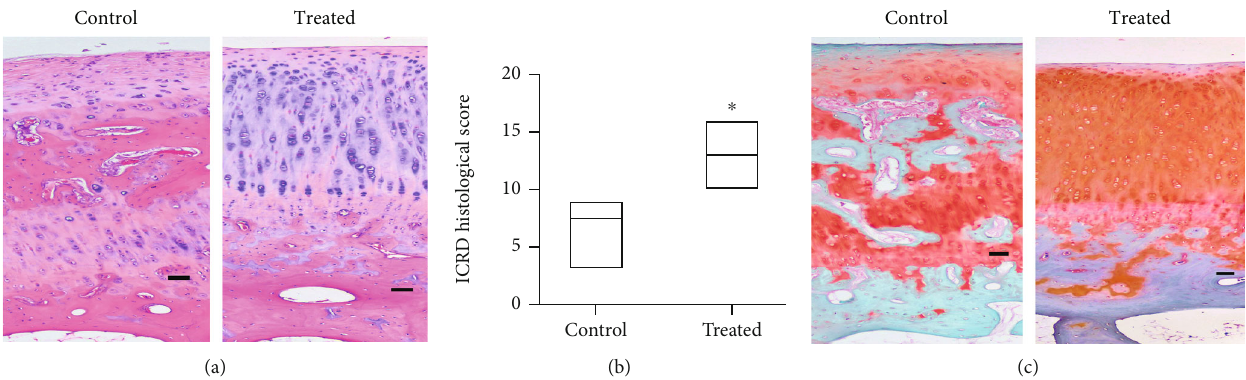
Figure 5: Histology and ICRS score of the rabbit osteoarthritis model after 12 weeks of experiments ( n = 4 ). (a) Representative image of histology of the cartilage in normal saline control and HUCMSC+HA-treated knees. Scale bar = 100 μ m . (b) The normal saline control joints show a signi fi cantly lower ICRS histological score than the joints which receive 1 × 10 7 HUCMSC+HA therapy ( n = 4 , p = 0 : 029 ). (c) The content of Safranin O staining after 12 weeks of experiments ( n = 4 ). Representative image of the Safranin O staining in the cartilage of normal saline control and treated knee. Scale bar = 100 μ m . ∗∗ p < 0 : 01